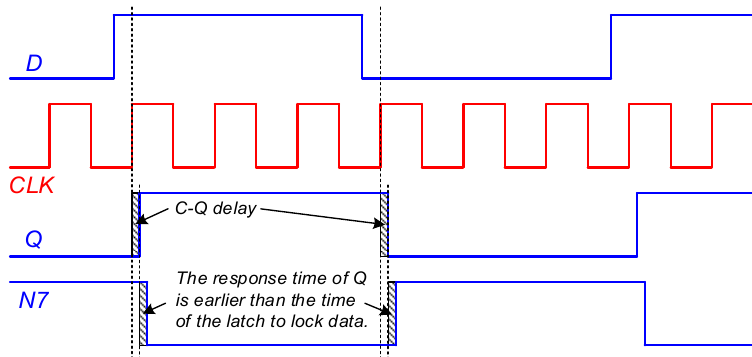
Figure 5. Operation waveform of the proposed design DNURF.